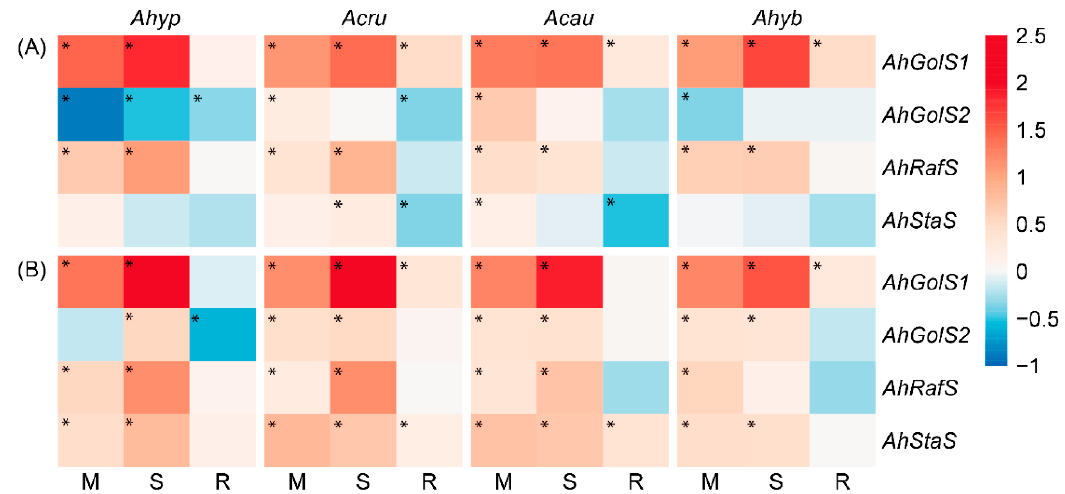
Figure 9. Relative expression of genes involved in the biosynthesis of raffinose family oligosaccharides in ( A ) leaves and ( B ) roots of Amaranthus hypochondriacus (Ahypo), A. cruentus (Acru), A. caudatus (Acau), and A. hybridus (Ahyb) plants subjected to moderate (M) or severe (S) water deficit stress, or allowed to recover from S, 1 day after normal watering was restored (R). Induced (normalized expression values ≥ 1.5; in red) and repressed (normalized expression values ≤ 0.5; in blue) gene expression values, represented in a log 10 basis, are highlighted with an asterisk at the upper left side of the cells. They were calculated according to the comparative cycle threshold method [28] using the AhACT7 , AhEF1a and Ah β Tub5 amaranth genes for data normalization.